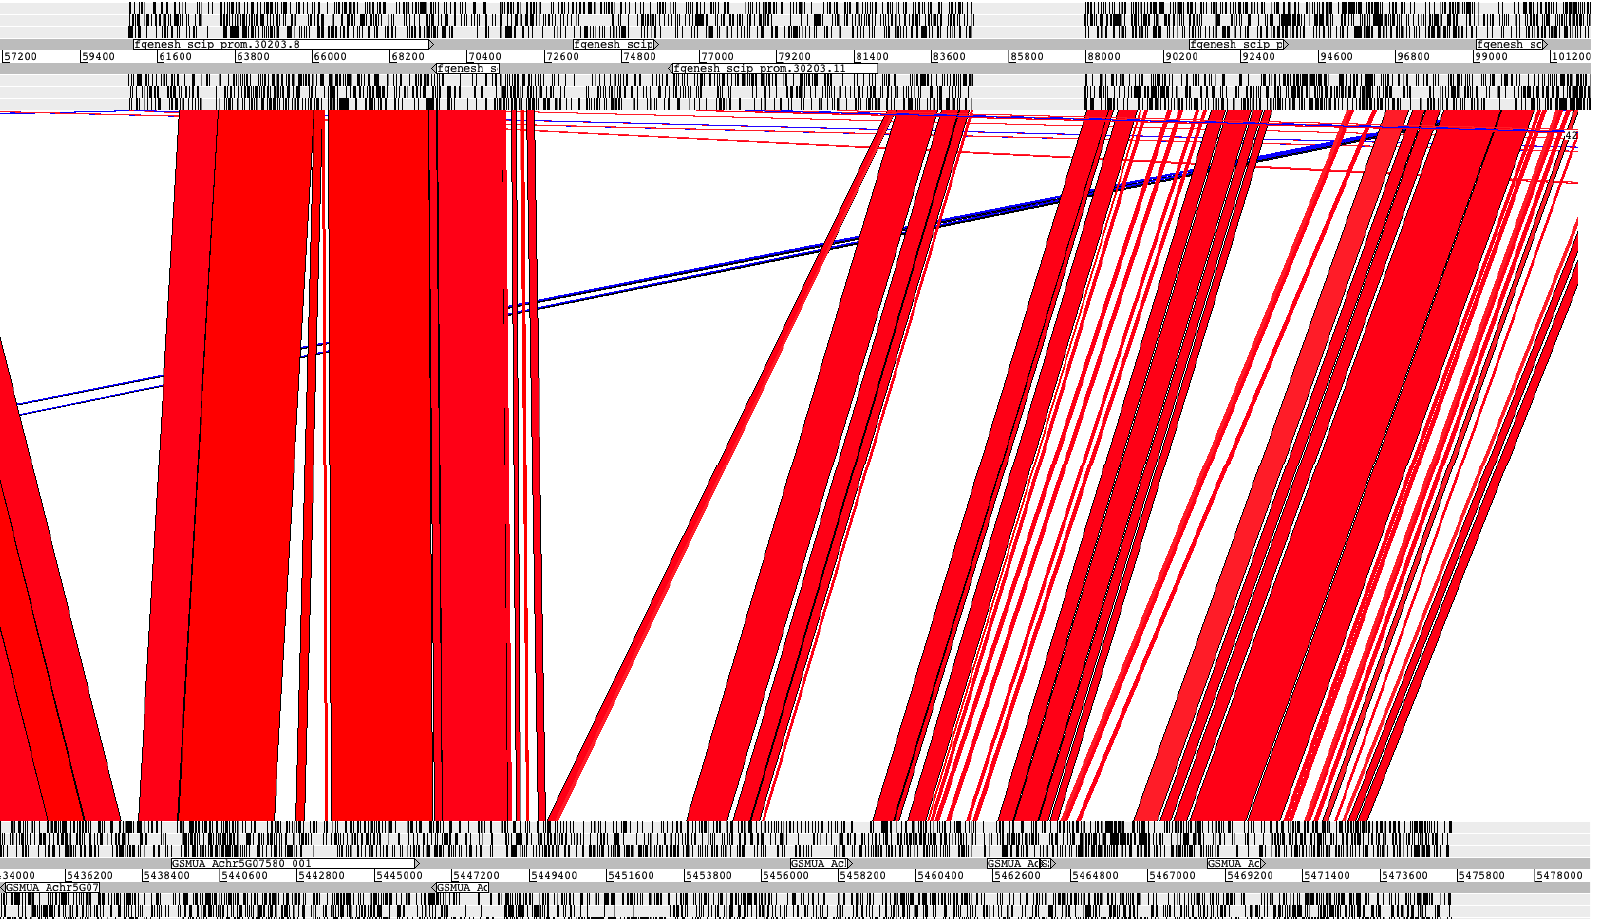
Figure 4. BLASTN alignment of an enset supercontig (GenBank: KB219804) against banana chromosome 5, displayed using the Artemis Comparison Tool